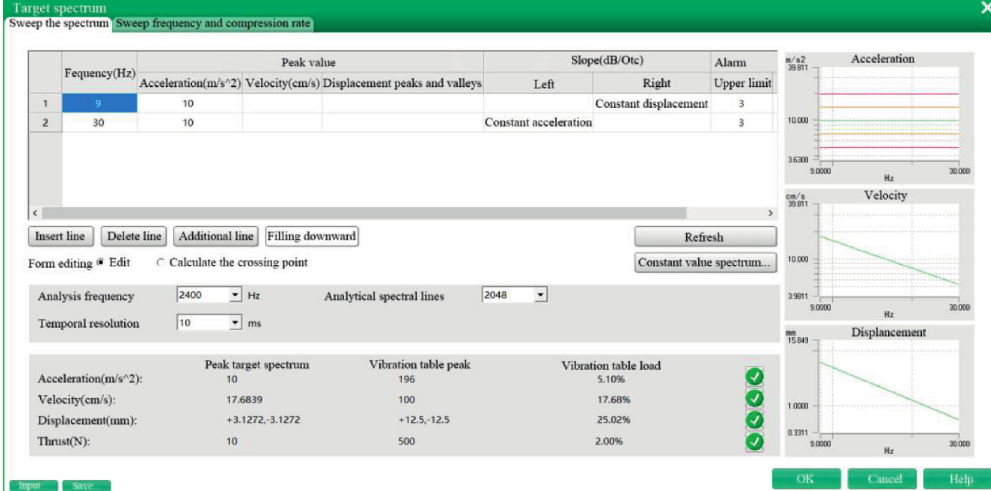
Figure 25: Setting the target